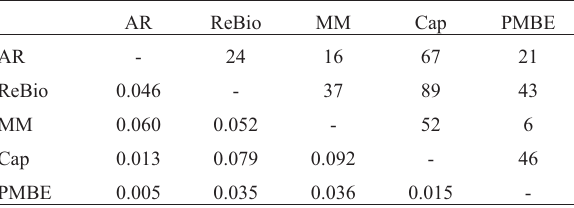
Table3 -Geneticstructureanalysis(F ST )withcpSSRmarkersbetweenar- eas in pairs in the lower diagonal and geographic distance in upper diago- nal